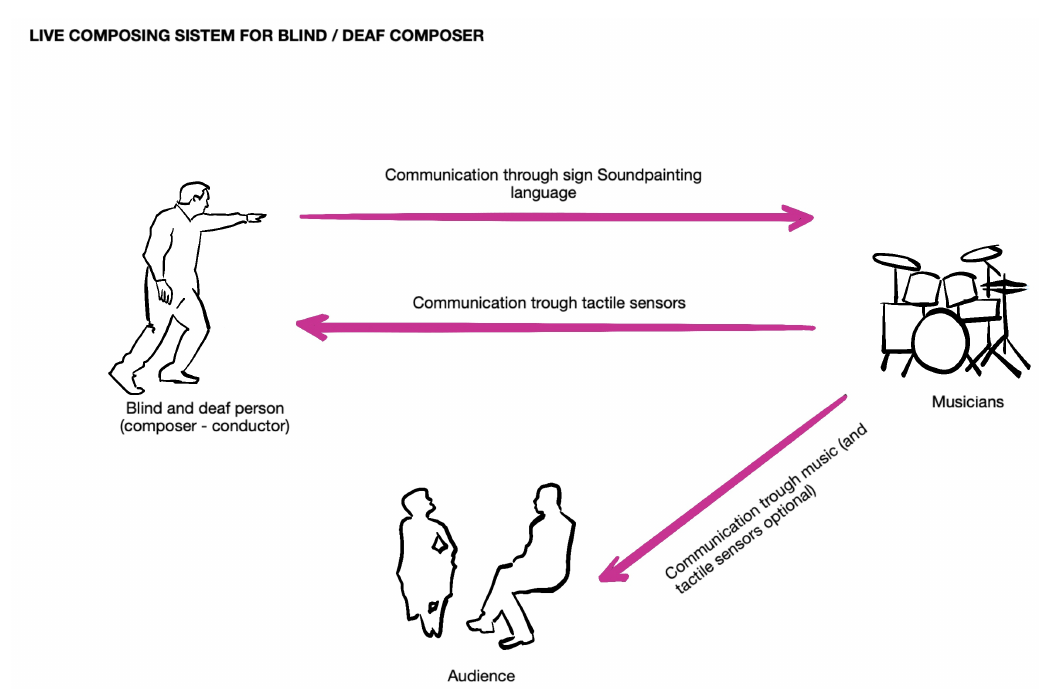
Figure 1. The types of communication between agents in the creative